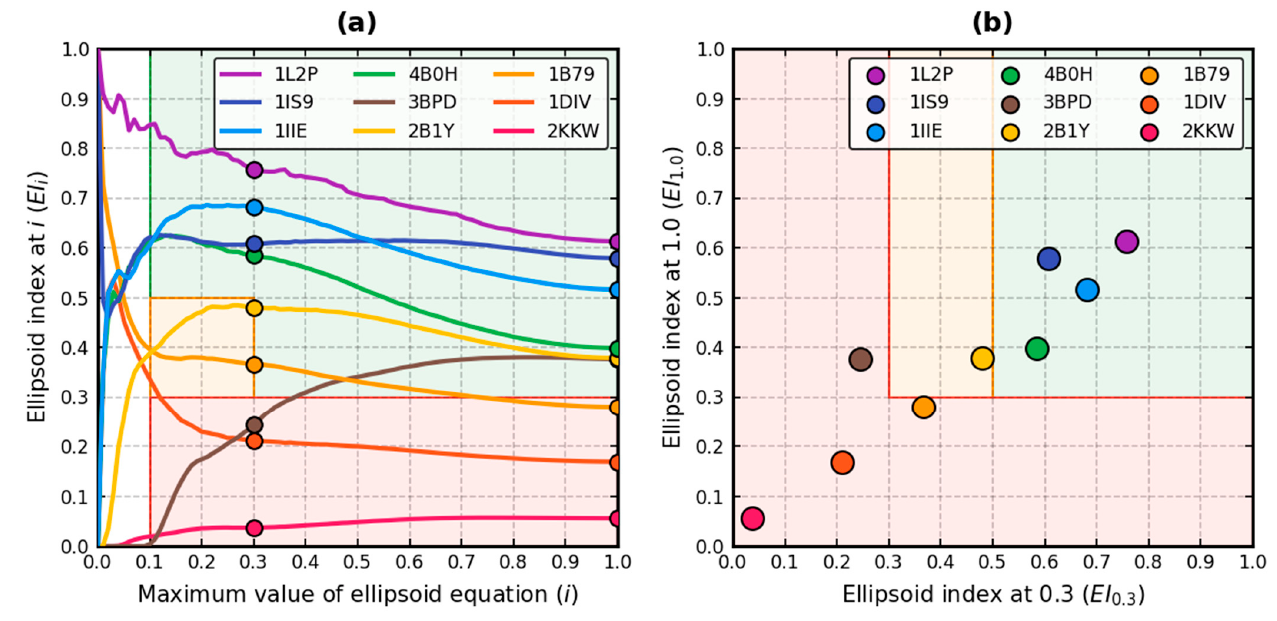
Figure 5. Ellipsoid profiles ( a ) and corresponding ellipsoid profile maps ( b ) of proteins from Table 3 using m = 3. Four colored zones can be seen underneath the profiles in Figures 5a and 6a: red, orange, green and white/transparent. These zones are visual cues for classification and comparison of proteins by the means of EP algorithm. They are coupled with two special values of parameter i : 1.0 and 0.3. EI 1.0 is the “main” index, reflecting everything